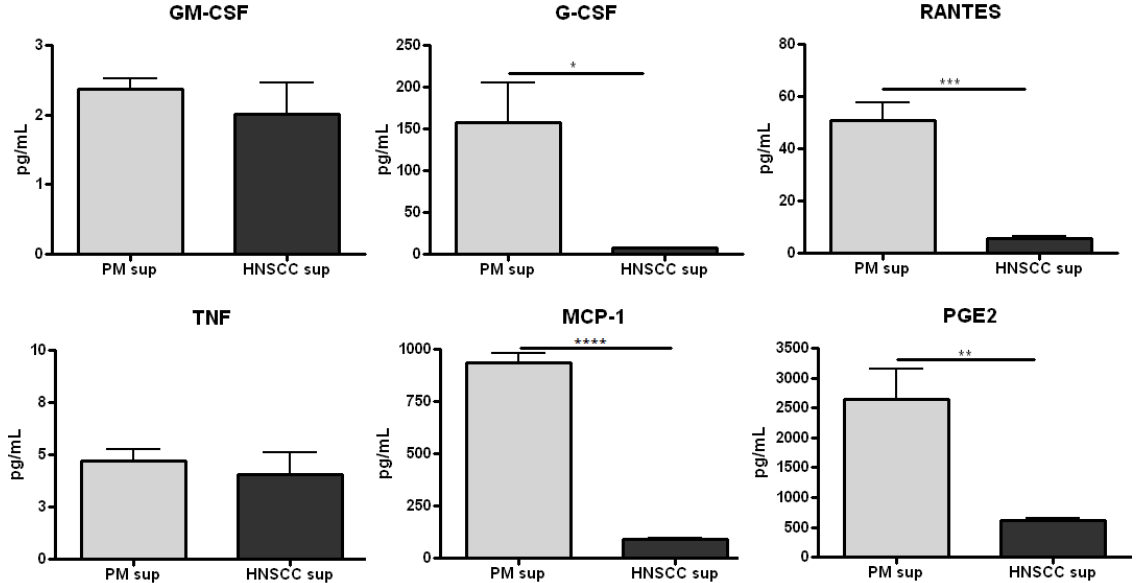
Figure 1. Premalignant lesion cells release significantly increased levels of pro-inflammatory mediators compared to HNSCC cells in vitro . Cells were grown to confluency and supernatant was collected after 48 h for cytokine/chemokine analysis. Data shown represent three independent experiments performed in duplicate. * p < 0.05 ** p < 0.01 *** p < 0.001 **** p <